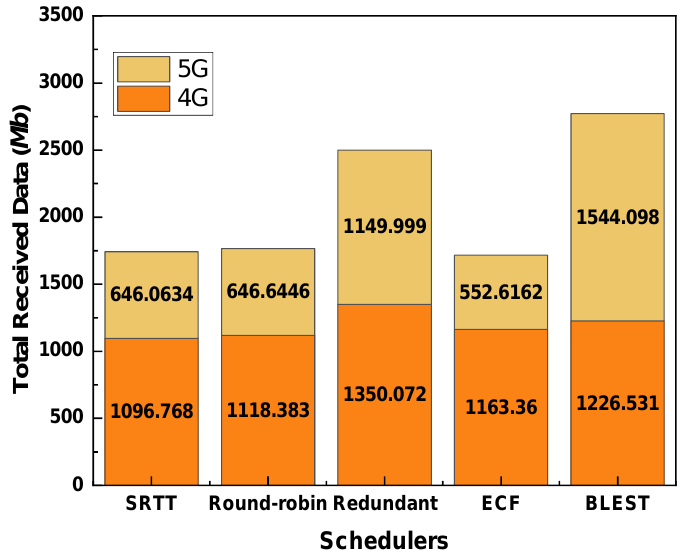
Figure 4. Performance of the tested MPTCP schedulers in terms of total received data for LIA as a CCA.